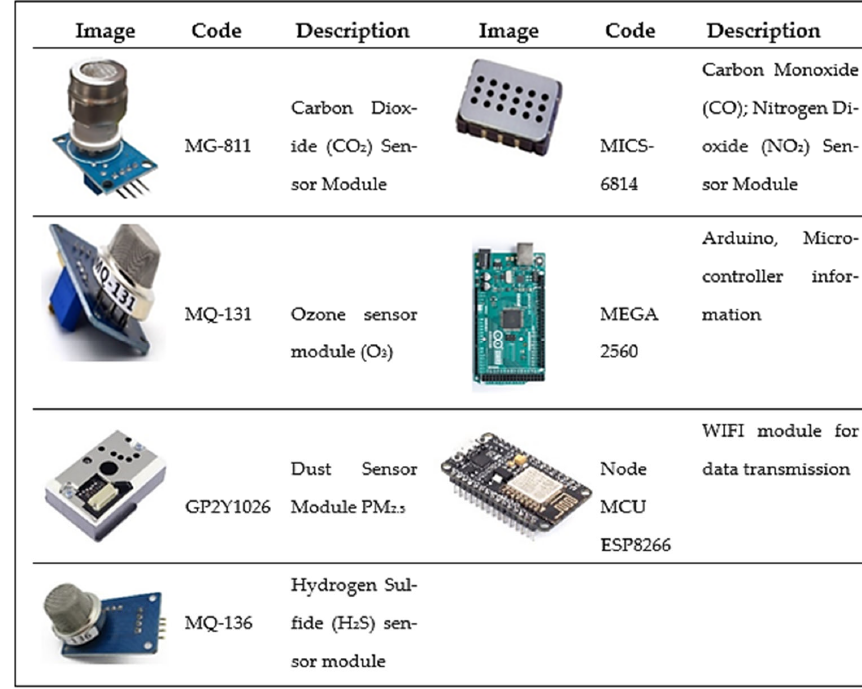
Figure 12. Electrochemical sensors used in the study.